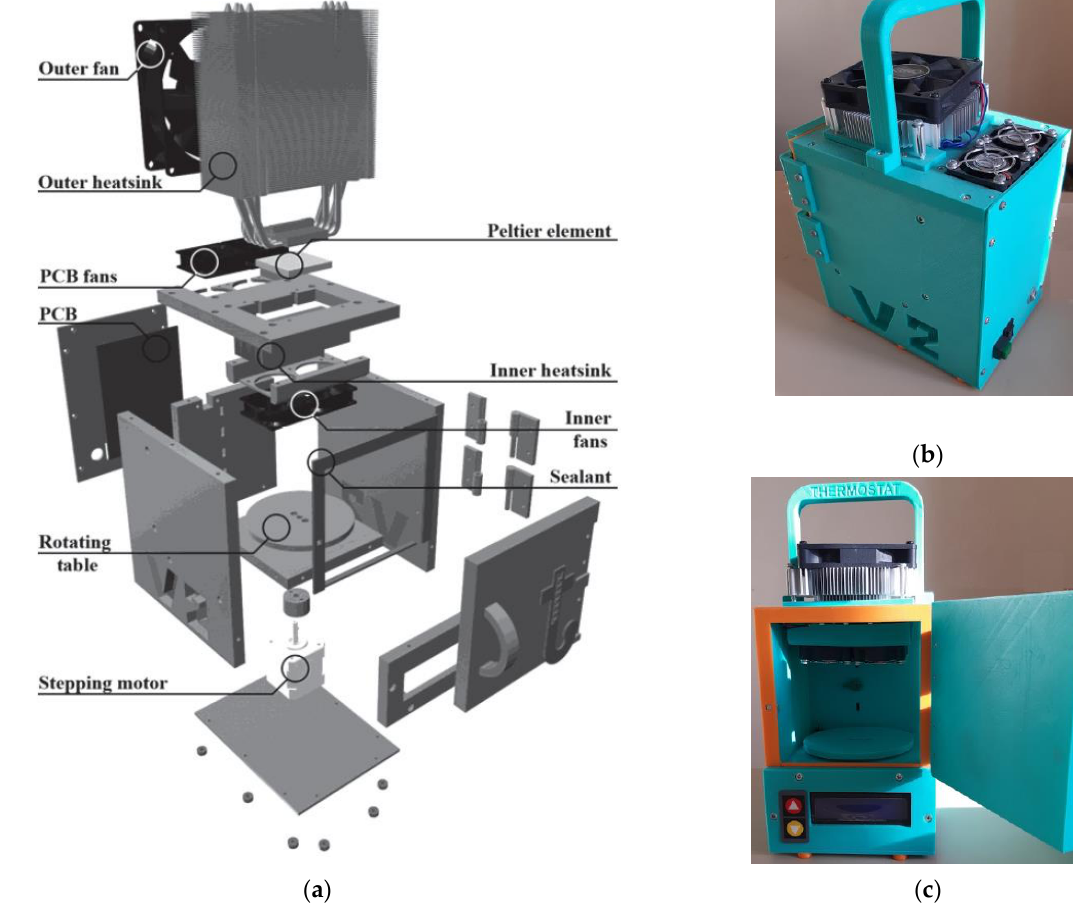
Figure 9. ( a ) Design of the thermostat showing internal elements; ( b ) layout of the thermostat in a 3D-printed housing, side view; ( c ) layout of the thermostat, general view.